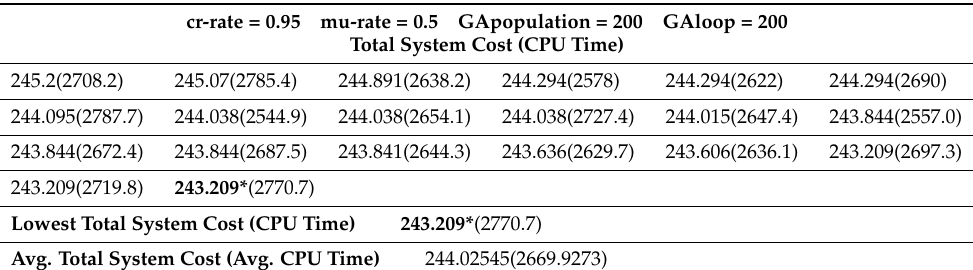
Table 5. The total system costs of 20 simulation runs obtained by ENUM–MGA for the n -stage standby system.